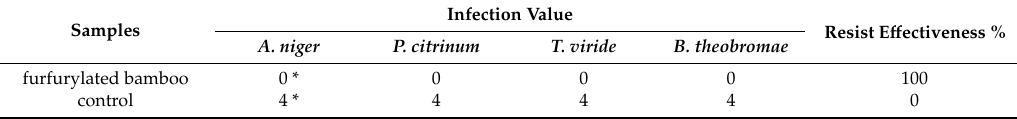
Table 3. Results of the mold-resistance test for furfurylated